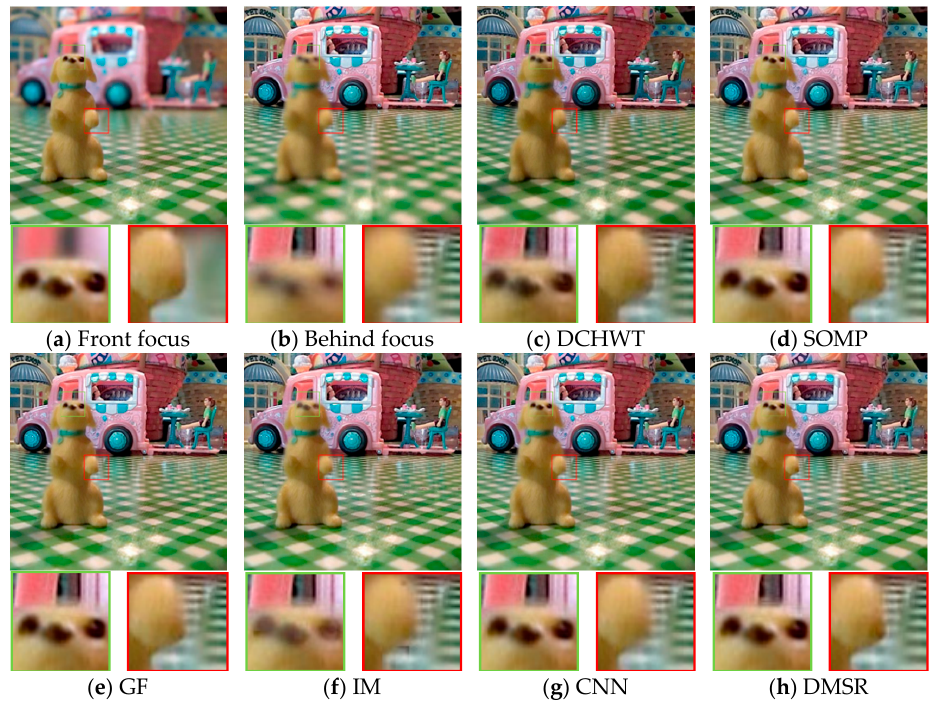
Figure 12. The “Lytro17” image pair and fusion results obtained by different fusion methods.